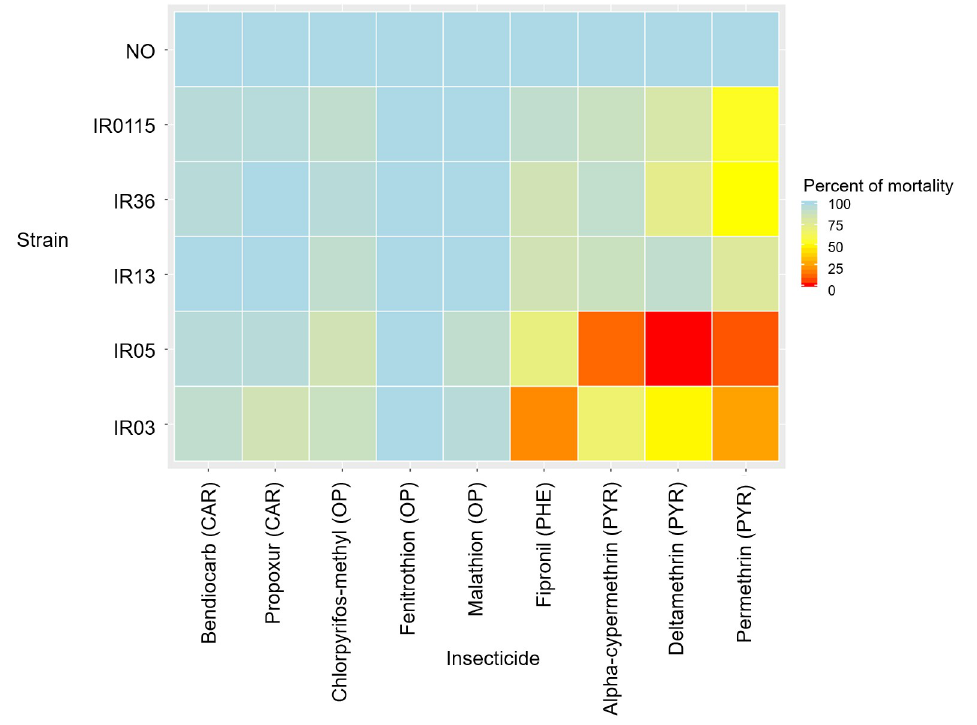
Fig 2. Heat map representing percentage 24-h mortality after exposure to diagnostic dose of several class of insecticides (CAR: Carbamates; OP: Organophosphates; PHE: Phenilpyrazole; PYR: Pyrethroids) for laboratory Aedes aegypti strains: IR13, IR36, IR03, IR05 and IR0115 and New Orleans (NO).